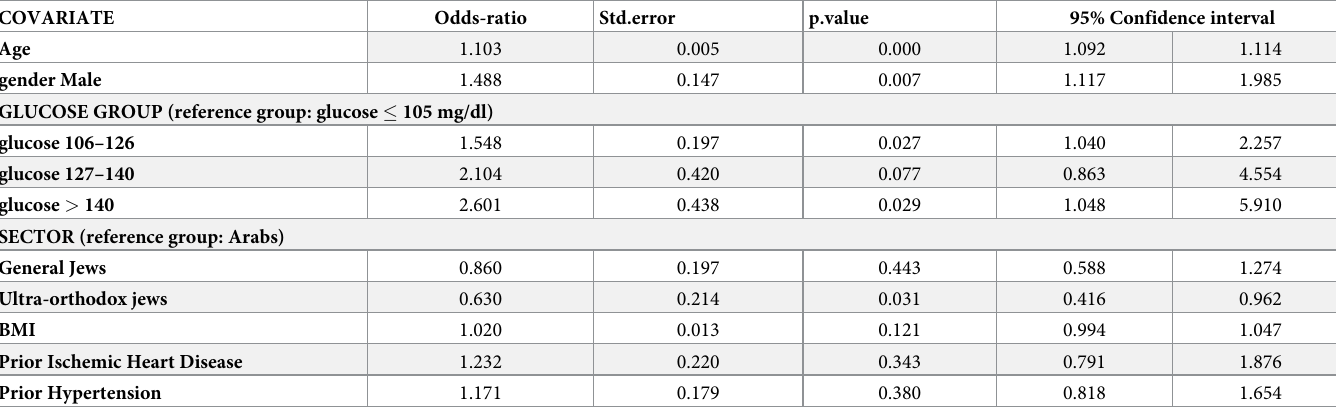
Table 2. Regression results for severe COVID-19 among non-diabetics (n = 10,763). COVARIATE